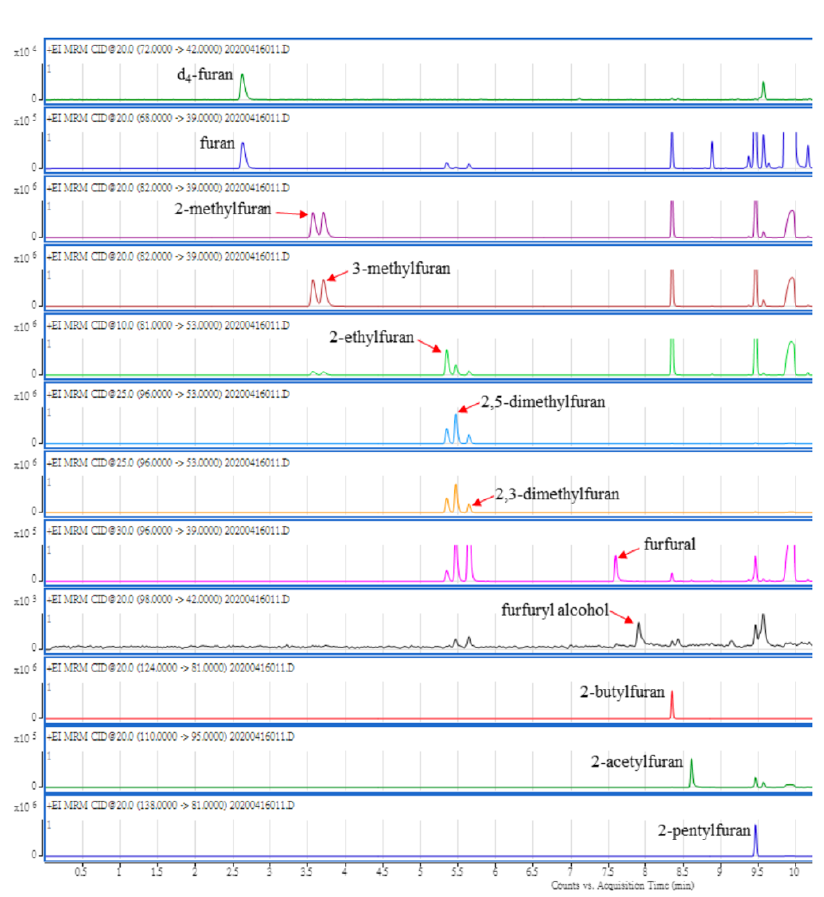
Figure 2. Furan and its 10 derivative standards, detected by GC-MS/MS in MRM mode.